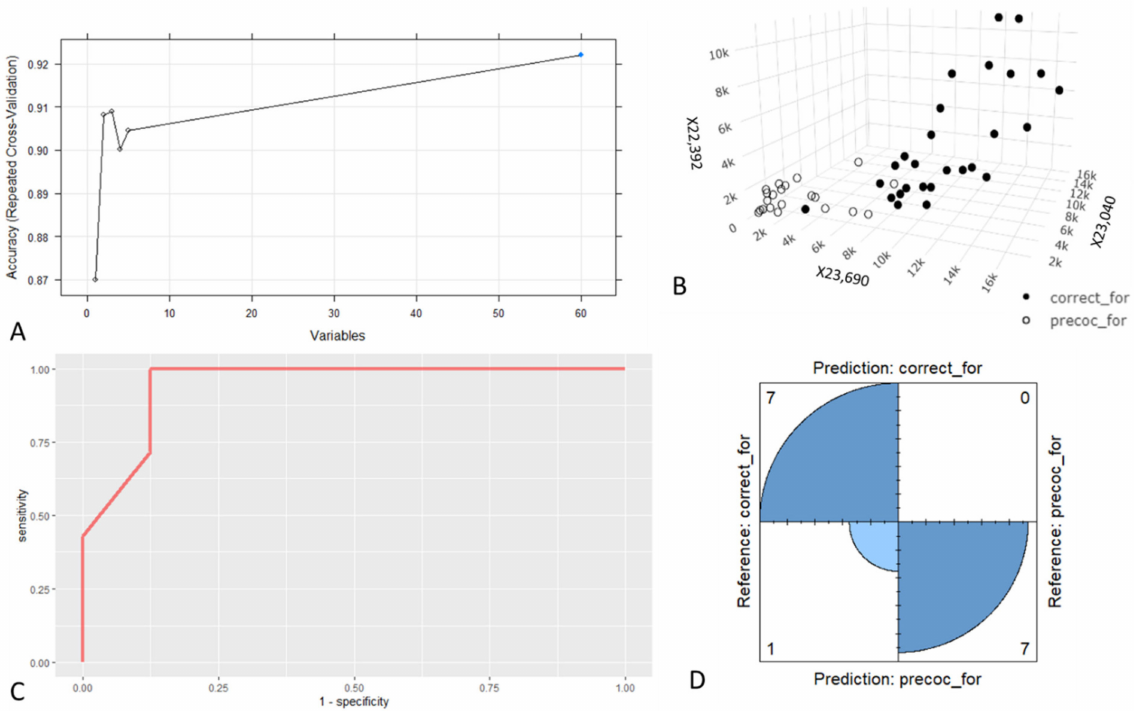
Figure 2. Foragers’ data. ( A ) Relation between the mean Accuracy of the model obtained with the forager training dataset (assessed through Repeated Cross-Validation) and the number of variables used. ( B ) Three-dimensional plot showing the relation between the intensity values of the three most informative variables and the category of the foragers in the train dataset. ( C ) ROC curve computed with the prediction of the RF model on the forager test dataset. ( D ) Four-fold plot showing the results of the confusion matrix produced with the prediction of the RF model on the forager test